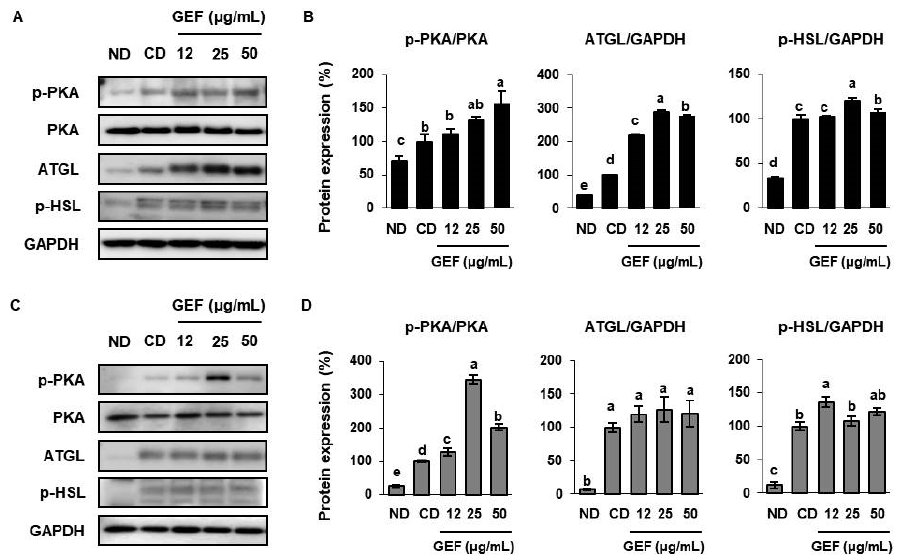
Figure 3. Effects of GEF on the phosphorylation of PKA, and expression of lipolytic enzymes in 3T3-L1s and SATs. ( A–B ) Expression of p-PKA/PKA and lipolytic enzymes (adipose triglyceride lipase (ATGL) and p-hormone-sensitive lipase (HSL)) in 3T3-L1s. ( C–D ) Expression of p-PKA/PKA and lipolytic enzymes in SATs. Treatments with different letters were significantly different, p < 0.05 (a > b > c > d > e).